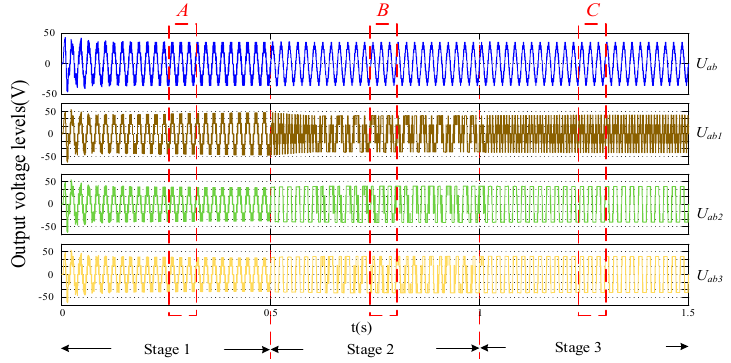
Figure 10. The output voltage levels waveforms of 3LNPC-CC.